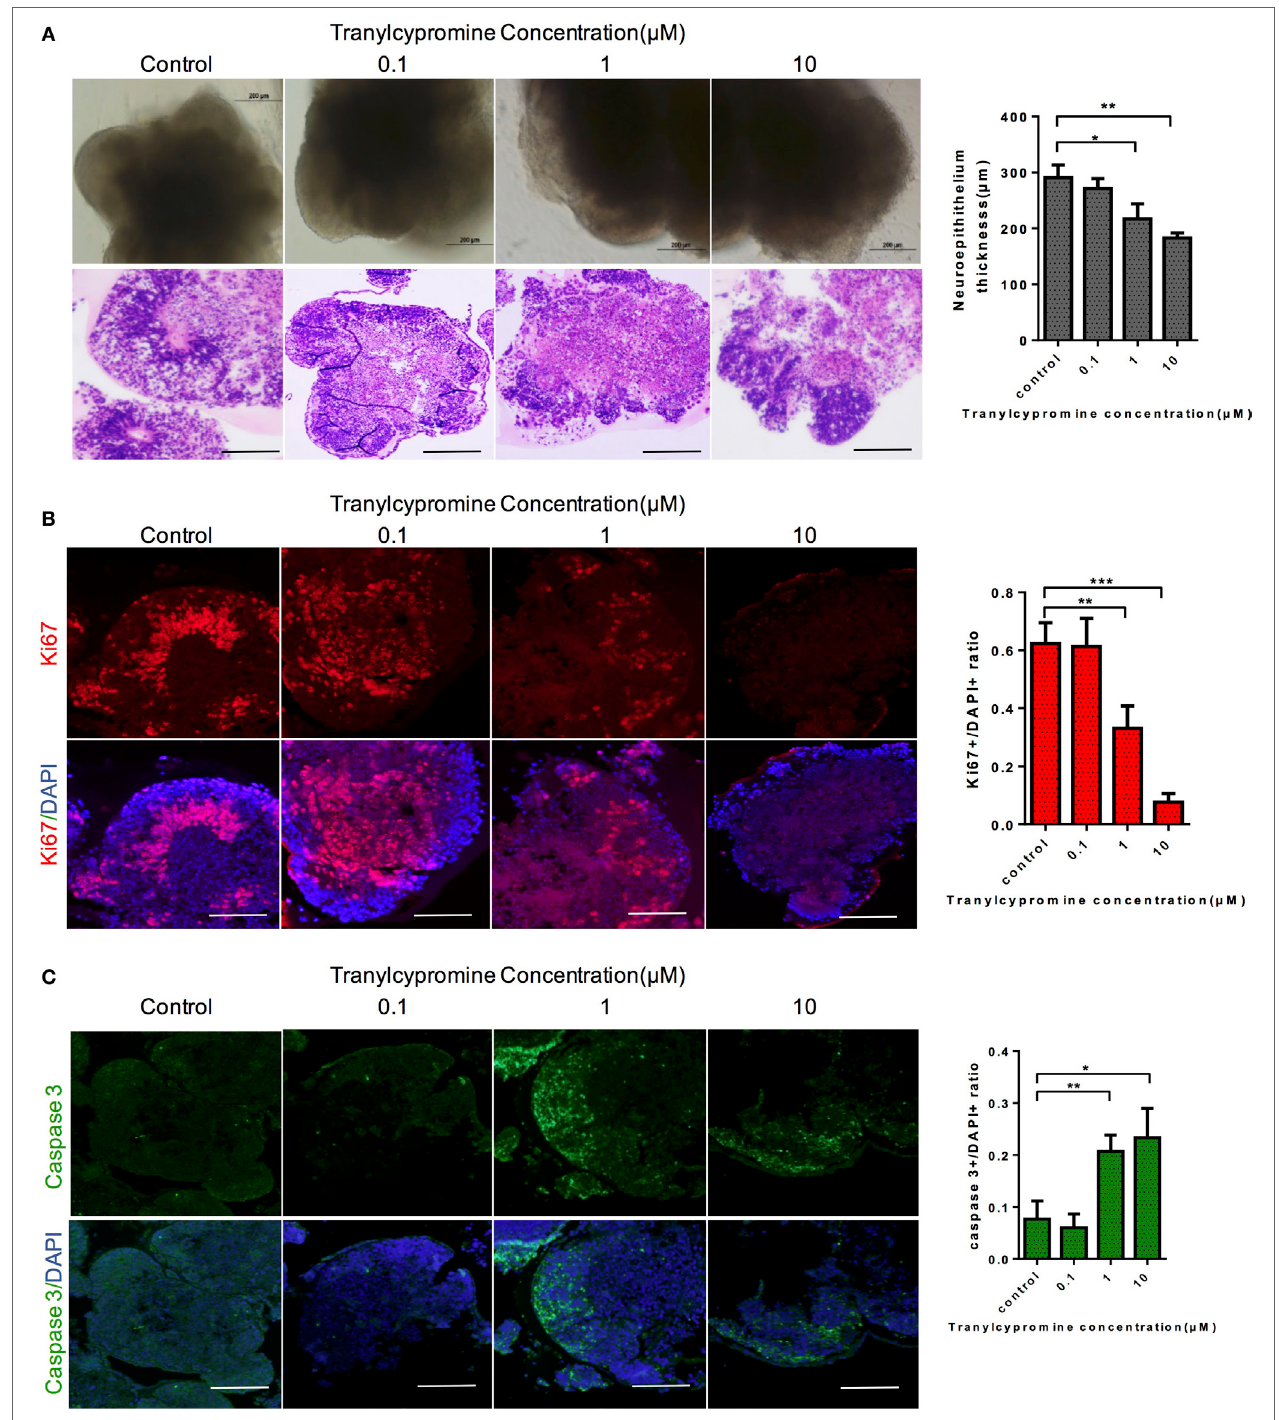
FigUre 3 | Tranylcypromine affected on cellular proliferation and apoptosis in human brain organoids. (a) Cerebral organoids response to tranylcypromine treatment were tested at three concentrations (0.1, 1, 10 µM). (B,c) Brain cellular proliferation and apoptosis rates were analyzed by Ki67 and scaspase3 (c) expression. Scale bars: 200